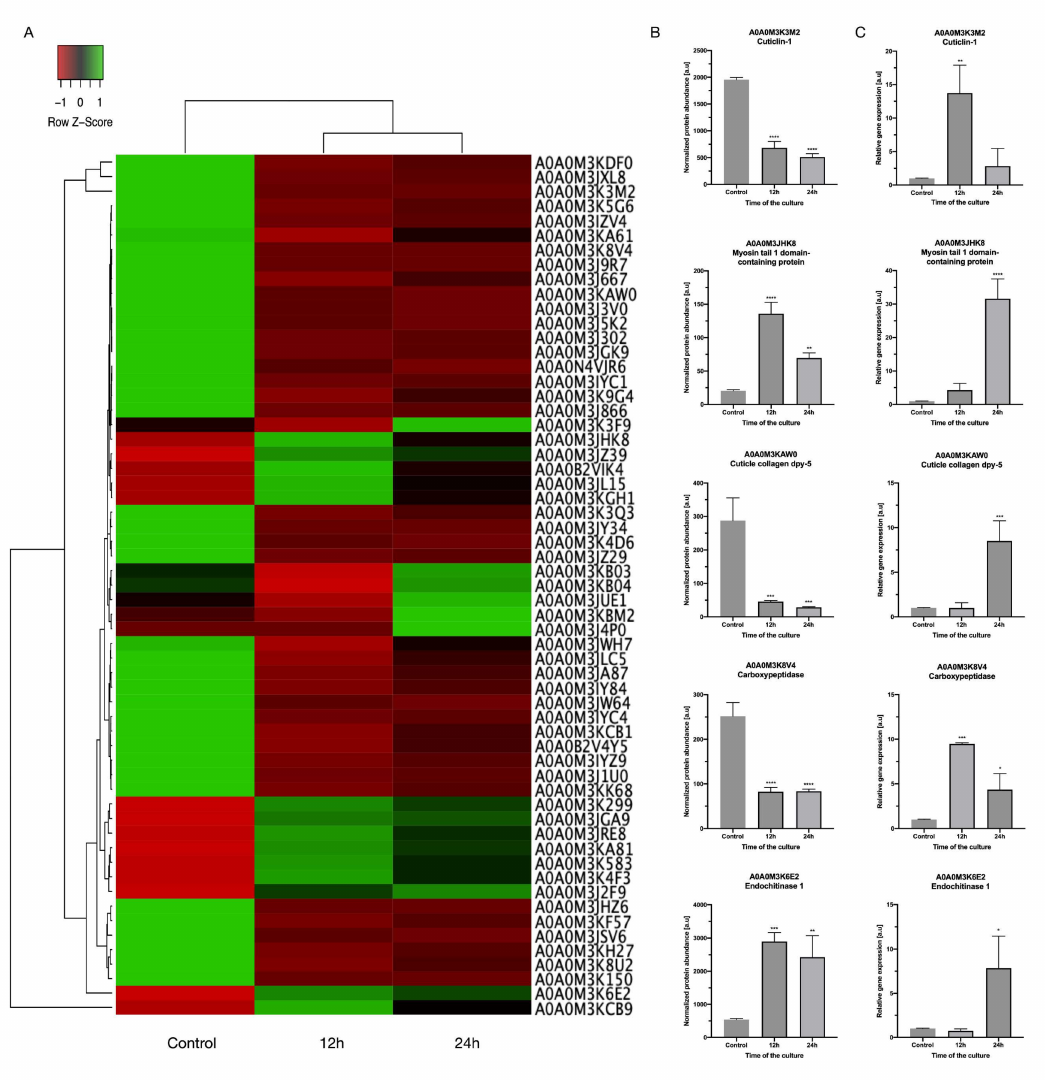
Figure 3. ( A ) Heat-map of all di ff erentially regulated proteins (DRPs). ( B ) The protein abundance profiles of selected DRPs. Presented values were normalized between the samples and are originally from LC-MS / MS analysis. ( C ) The transcription levels of selected genes encoding chosen DRPs. The control is shown as normalized to a value 1, and the samples indicate the changes relative to the control. p -values below 0.1234 (non-significant) were considered statistically significant, where 0.0332 (*), 0.0021 (**), 0.0002 (***), and < 0.0001